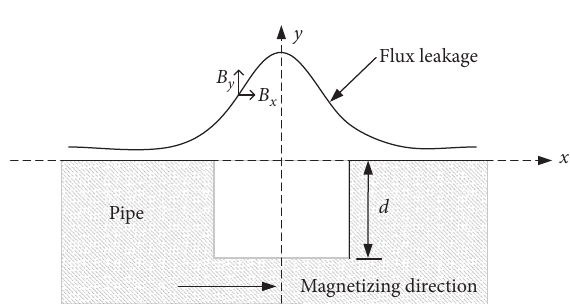
Figure 2: Illustration of magnetic flux leakage of a simple defect.